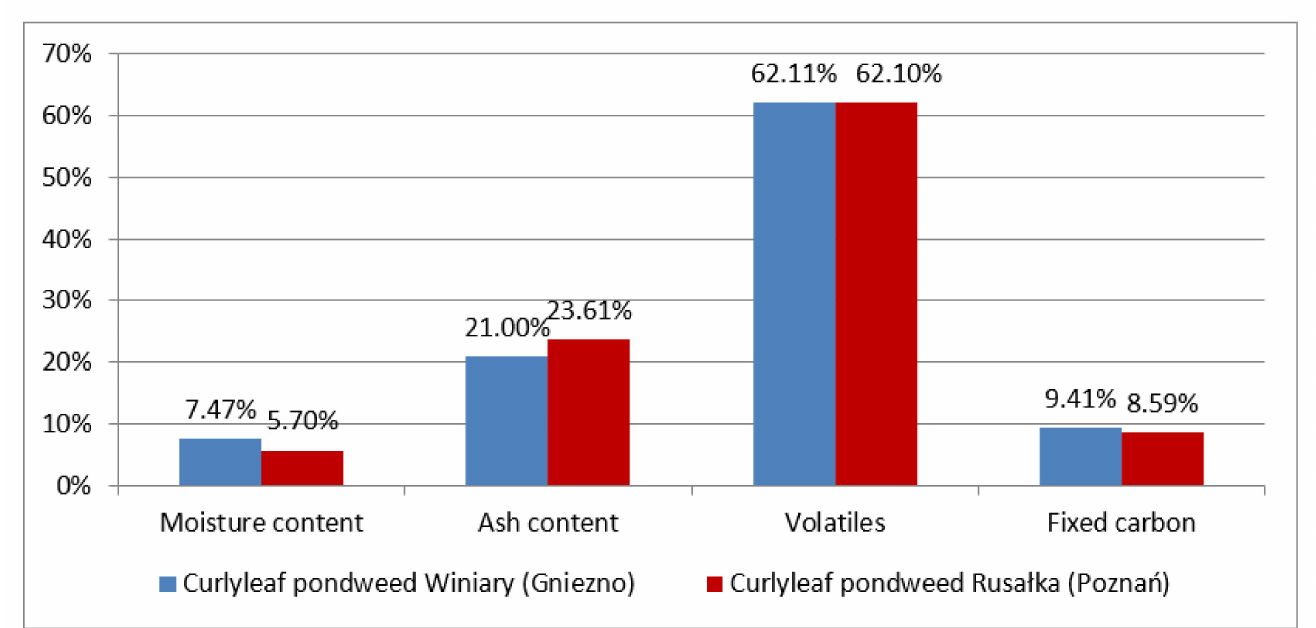
Figure 1. Proximate analysis results for the curly-leaf pondweed samples